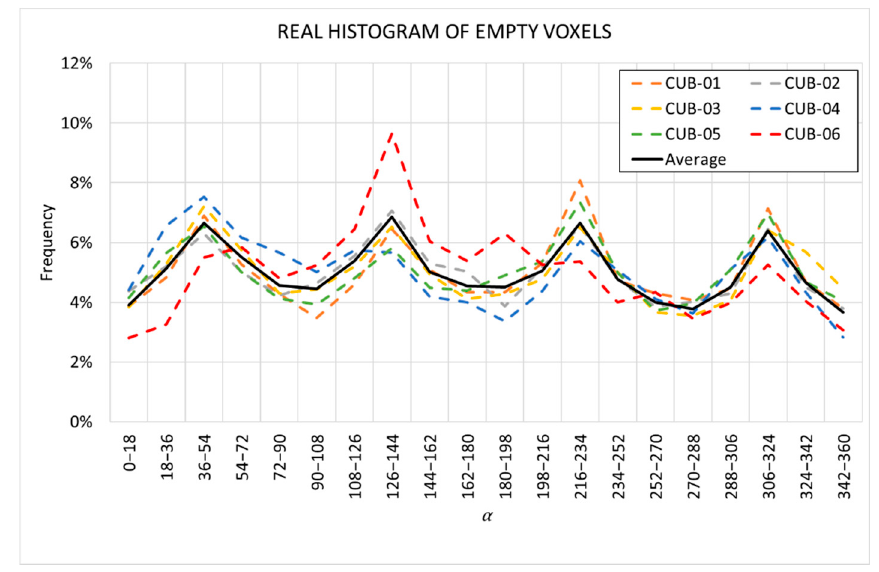
Figure 10. Radial test. Theoretical histogram of empty voxels according to a random distribution.